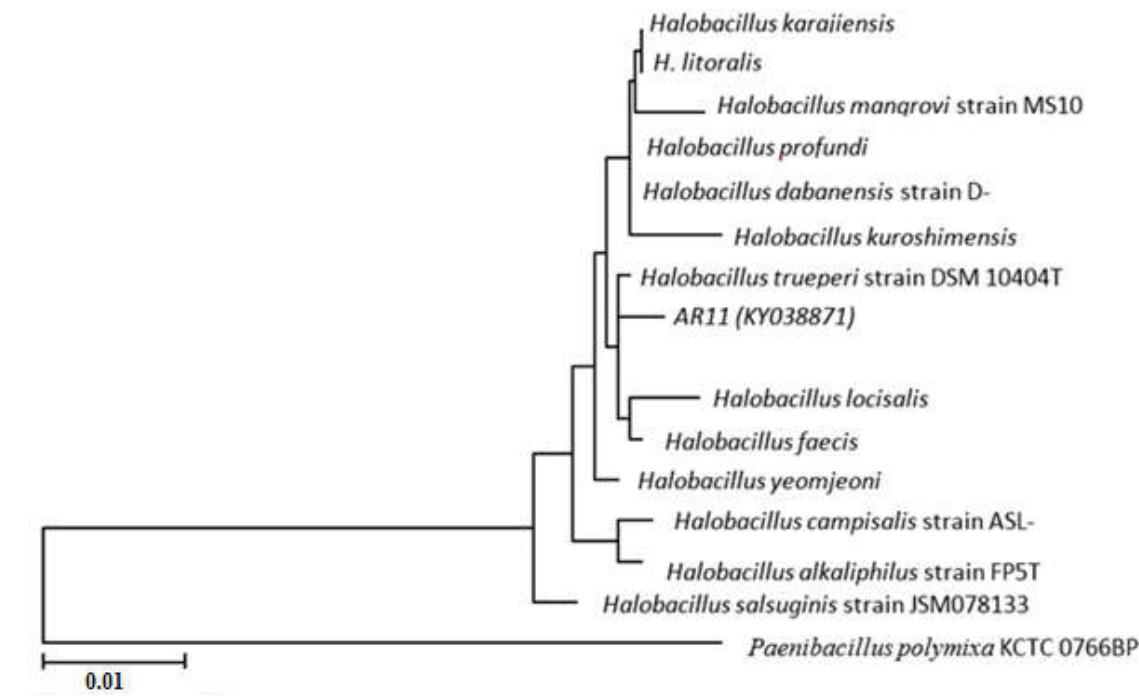
Fig 6. Phylogenetic tree based on 16S rRNA sequences, showing the relationship of the isolate AR11 to other members of the genus